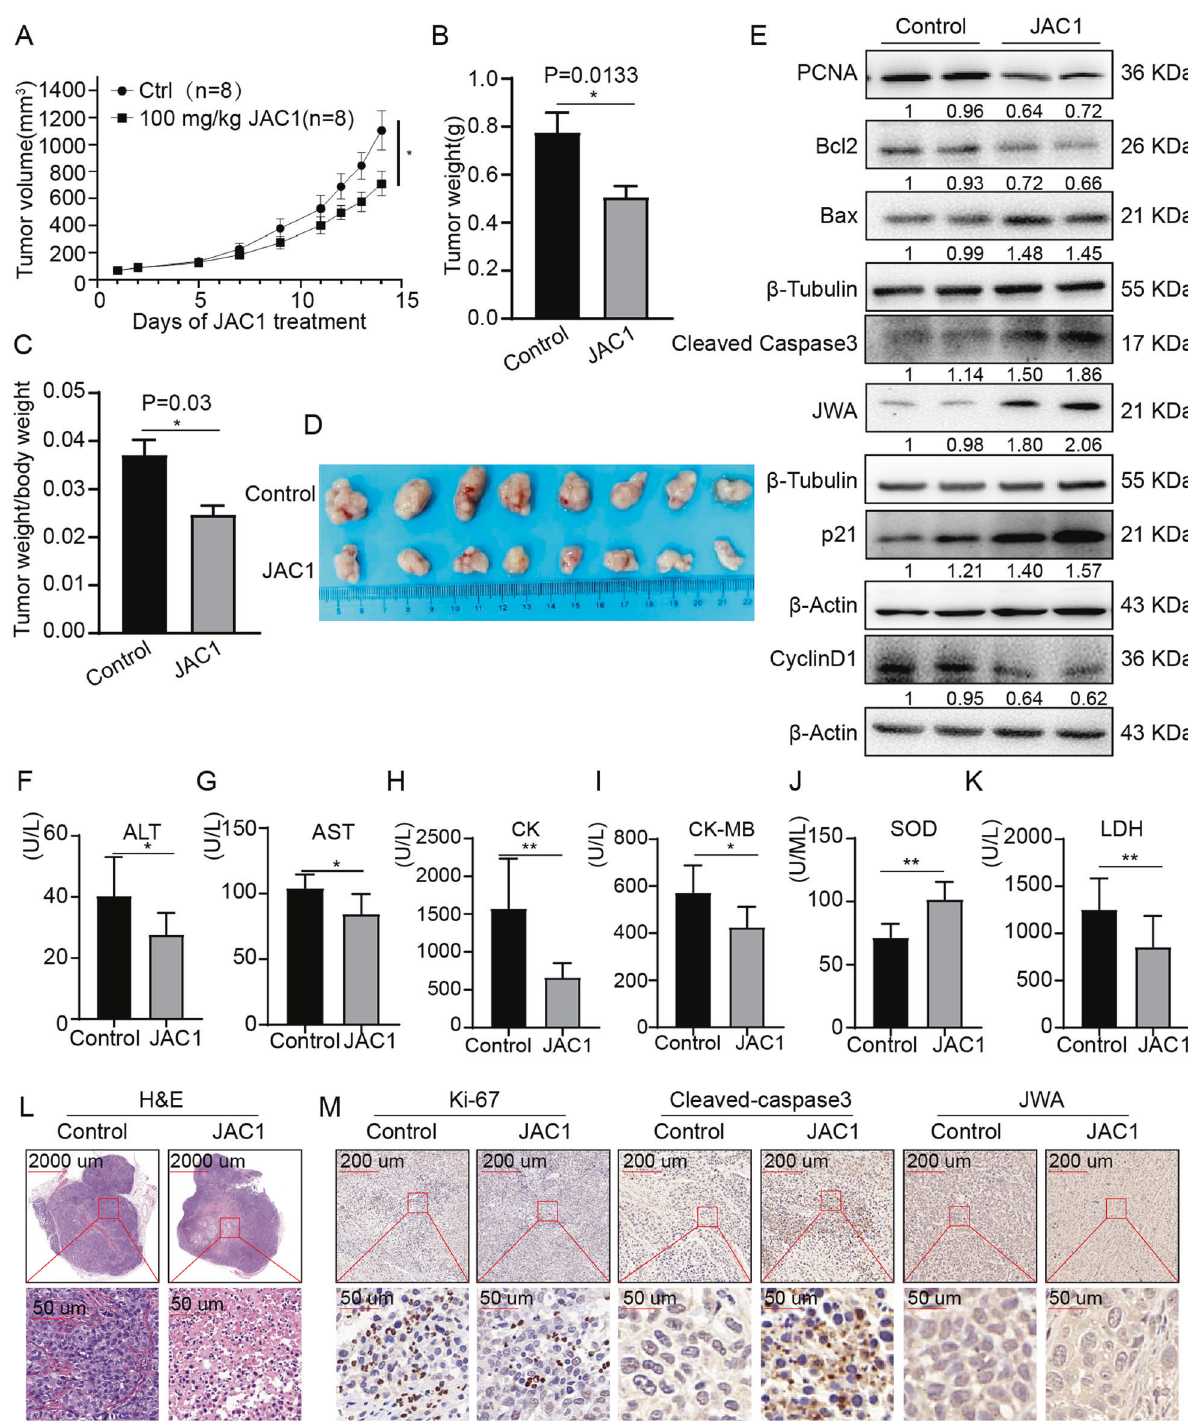
Fig. 4 JAC1 suppresses tumor growth in TNBC xenografted mice. A The tumor growth curves of MDA-MB-231 cells injection in Control and JAC1 treated groups ( n = 8). B The tumor weight in Control and JAC1-treated groups ( n = 8). C The ratio of tumor weight/body weight in Control and JAC1-treatde groups ( n = 8). D The representative images of subcutaneous tumors in Control and JAC1 treated groups ( n = 8). E Analysis of the expression levels of indicated molecules in tumor tissues of MDA-MB-231 cells tumor-bearing mouse models by Immunoblotting. F – K The serum biochemical indexes (ALT, AST, CK, CK-MB, SOD, LDH) in control and JAC1-treated mice ( n = 8). L H&E staining of tumor tissues in Control and JAC1 treated groups . M IHC staining of Ki-67, Cleaved caspase3, and JWA in Control and JAC1-treated tumor tissues. * P < 0.05; ** P < 0.01. N.S. no signi fi cant